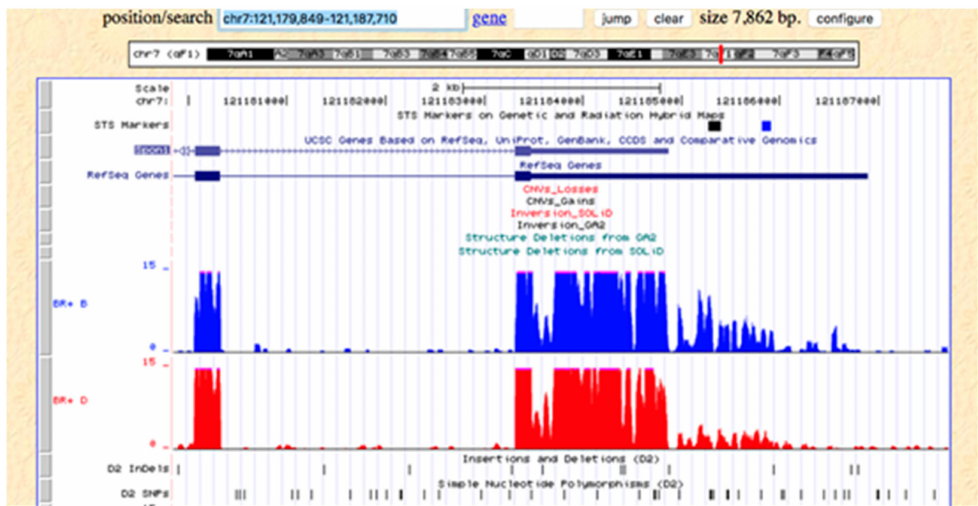
Figure 10. Diagram of Spon1 expression from 5 (cid:48) to 3 (cid:48) UTR (left to right) the top (blue) figure is C57BL / 6J and the bottom (red) figure is DBA / 2J. The figure shows greater expression in the 3 (cid:48) UTR for C57BL / 6J compared to that for DBA /